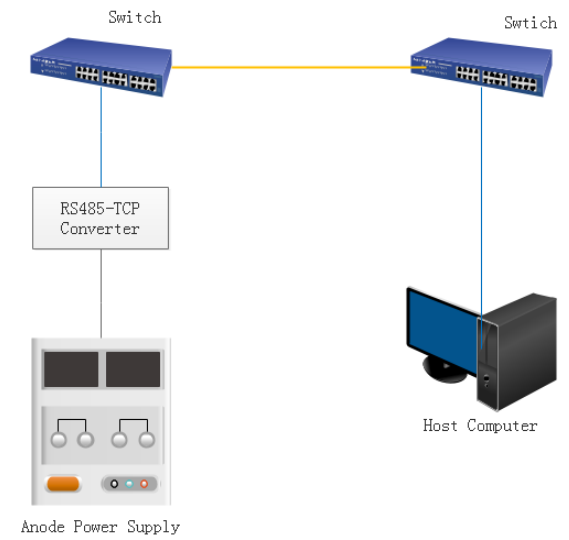
Fig. 1. The architecture of GYCOM anode power control.